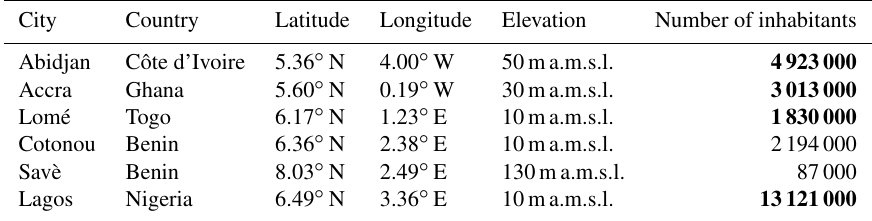
Table 1. Characteristics of the studied cities with country, latitude, longitude, elevation above mean sea level (a.m.s.l.), and number of inhabitants of urban agglomerations. The population in bold is given for the year 2015 according to the World Urbanization Prospects report (United Nations report, 2011). National general population and habitat census is used to estimate the population of Cotonou and Savè (INSAE report,